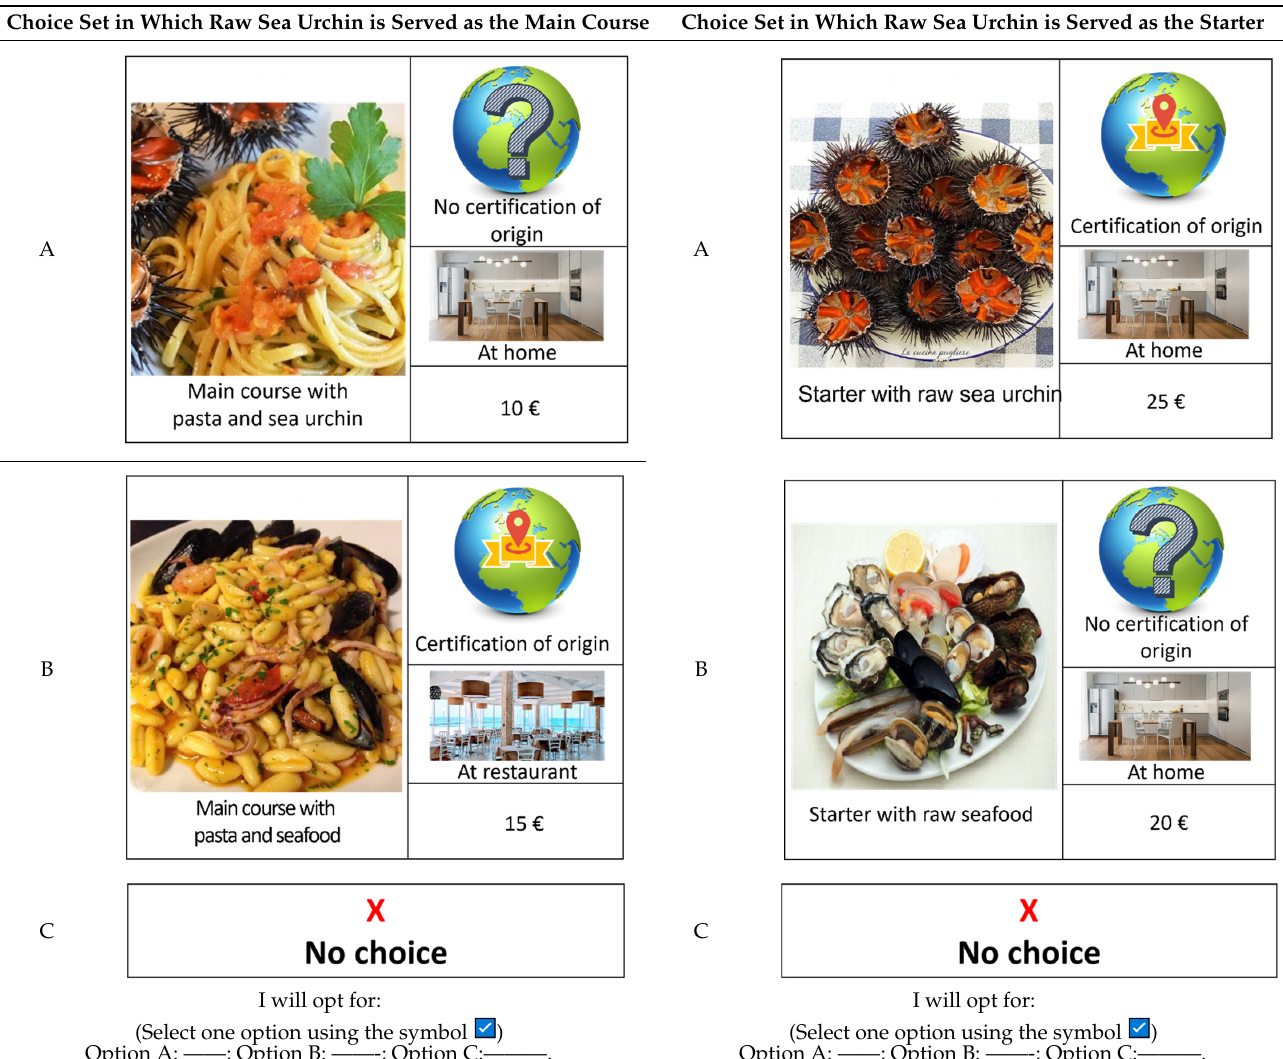
Table 2. Example of a set choice used in the survey. Choice Set in which Raw Sea Urchin is Served as the Choice Set in which Raw Sea Urchin is Served as the Main Course Starter